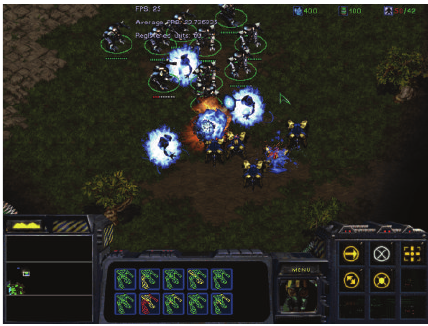
Figure 18: StarCraft: Brood War with the modified unit AI. The selected Goliaths are prioritizing Dragoons instead of the Archons in front of them because of their lower